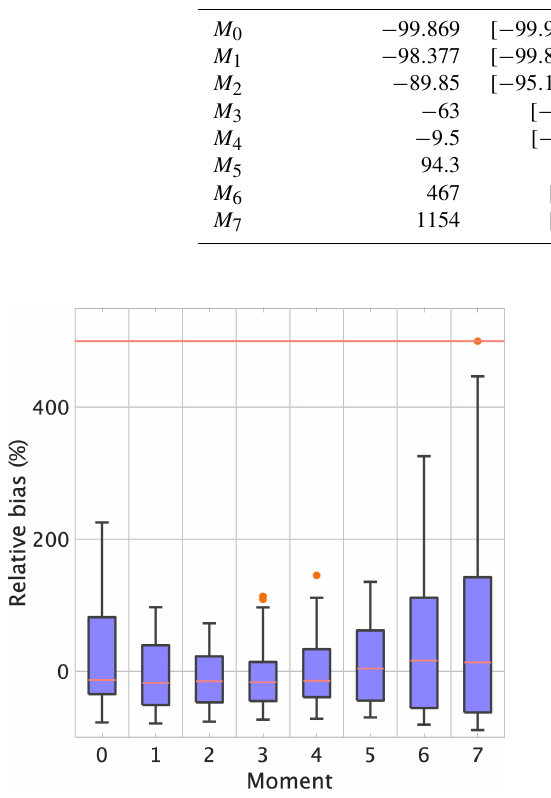
Figure 12. As in Fig. 11 except that the incomplete 2DVD DSDs are used to determine h(x) (see dashed line in Fig. 7). Inset shows magnified box plots for M 0 through M 2 . The orange horizontal line on top indicates the upper inner